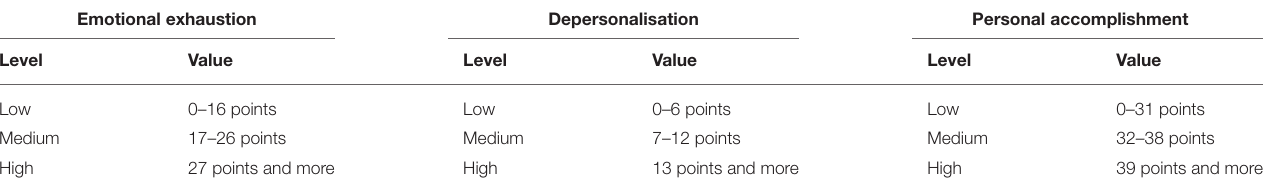
TABLE 1 | The limit values of the calculated